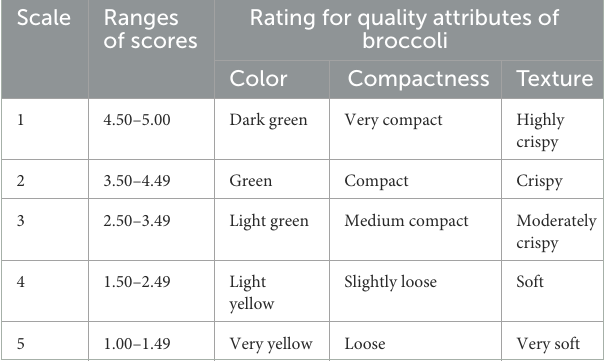
TABLE 1 Description of numerical ratings for broccoli quality [According to a 1 to 5-point hedonic scale (39)].